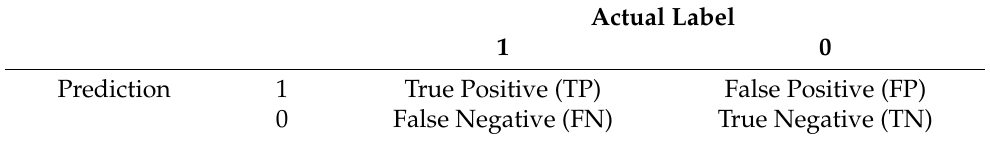
Table 1. Simple binary classification